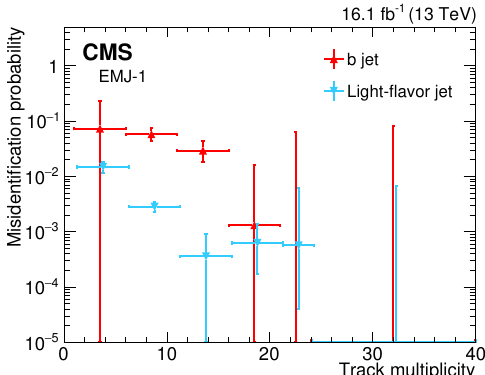
Figure 5 . Measured misidenti(cid:12)cation probability distribution as a function of track multiplicity for the EMJ-1 criteria group de(cid:12)ned in table 2. The red up-pointing triangles are for b jets while the blue down-pointing triangles are for light-(cid:13)avor jets. The horizontal lines on the data points indicate the variable bin width. The uncertainty bars represent the statistical uncertainties of (cid:15) f1 , (cid:15) f f f2 , b1 , and b2 in eq. (5.5), where the uncertainties in intervals [38].